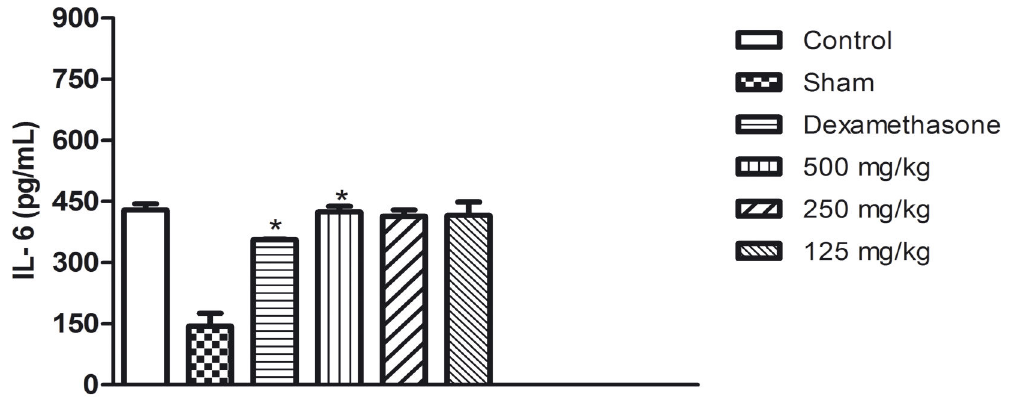
Figure 6. IL-6 (pg/mL) levels after the end of carrageenan-induced pleurisy assay in exudate of the pleural cavity of mice previously treated with aqueous seed extract. *p<0.05 in comparison with control by ANOVA followed by Newman-Keuls test. doi: